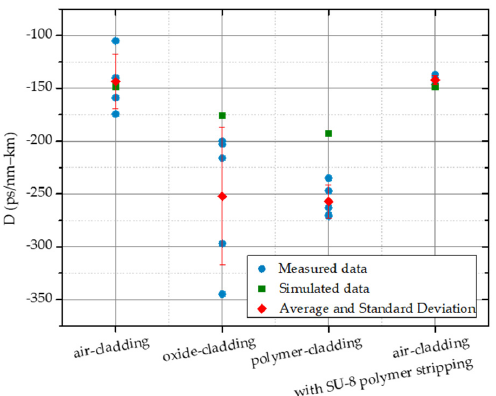
Figure 10. Simulated and measured dispersion parameters for air-, oxide-, SU-8 polymer-cladding, and air-cladded resonators with polymer and air-cladded resonators with polymer stripping.